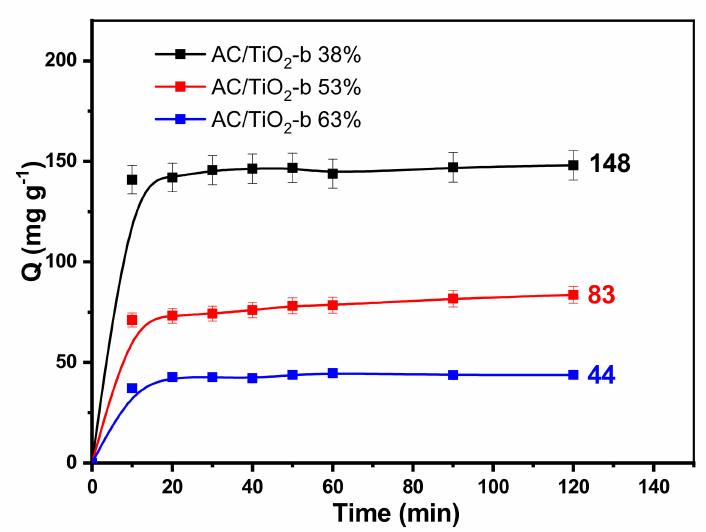
Figure 6. Concentration of CBZ adsorbed on AC/TiO 2 -b as a function of time, [CBZ] = 15 mg L − 1 , [AC/TiO 2 -b] = 0.1 g L − 1 , and T = 25 ◦